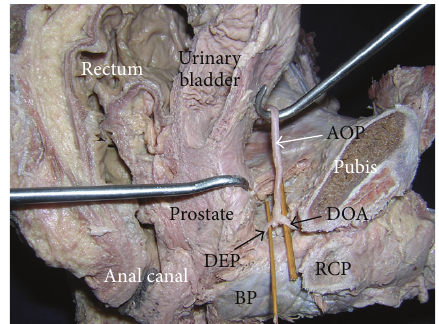
Figure2:Sagittalsectionofthepelvisshowingthesectionalviewsof rectum, canal, urinary bladder, prostate, and the pubis. (AOP: artery of penis, BP: bulb of penis, DEP: deep artery of the penis, DOA: dorsal artery of the penis, and RCP: right crus of the